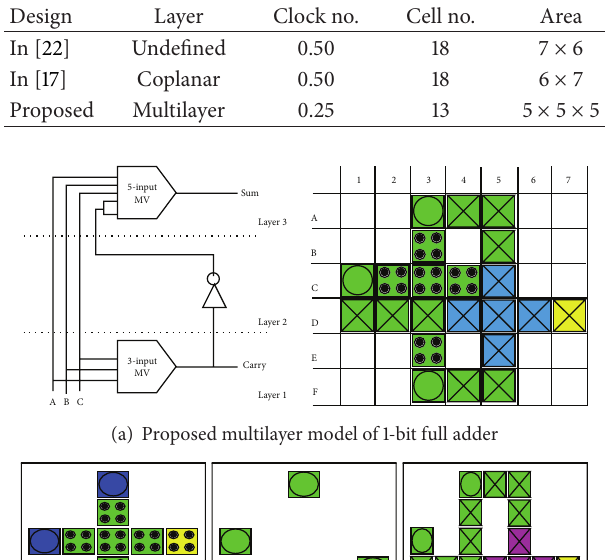
Table 1: Comparison of five-input majority gate.